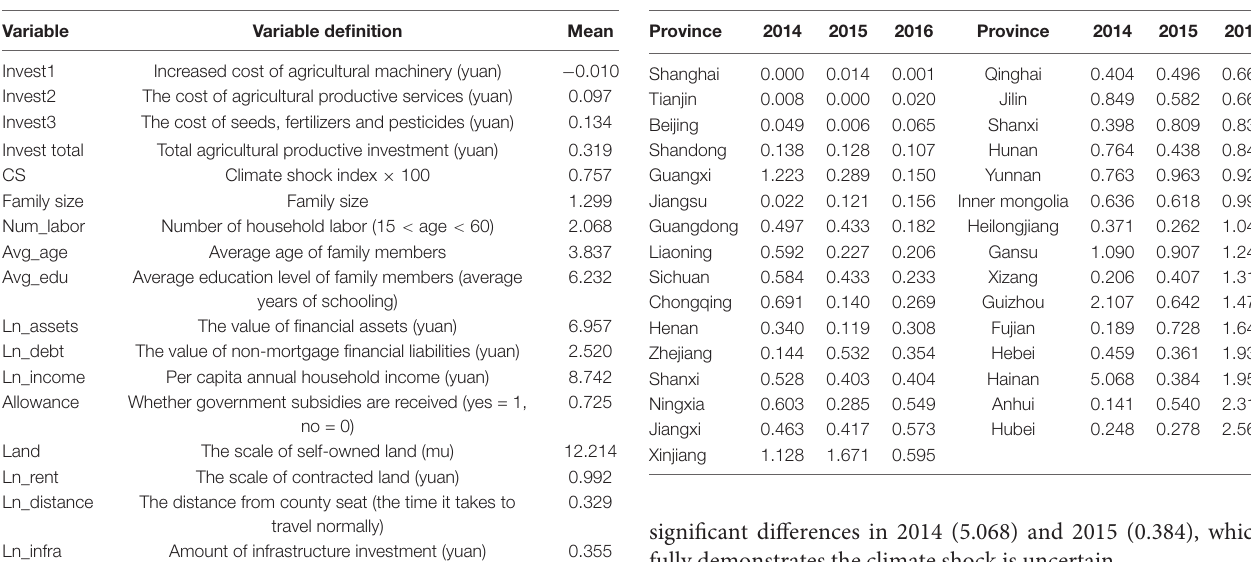
TABLE 1 | Variable definition. TABLE 2 | Climate shock index by province (2014–2016).